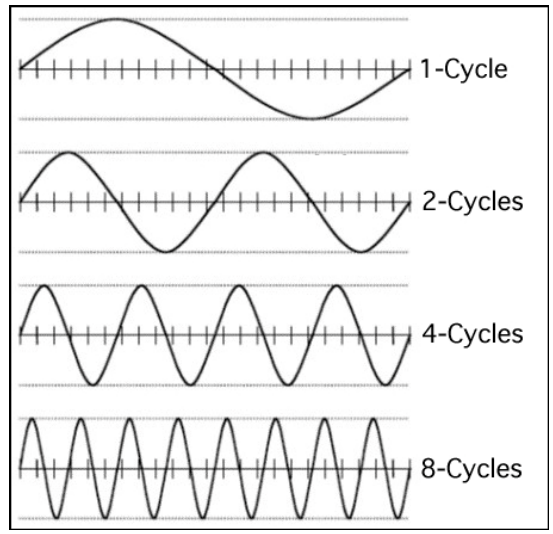
Figure 7. Waveform patterns over a 24-pixel field. Top to bottom: 1, 2, 4, and 8-cycle windows. Contrast